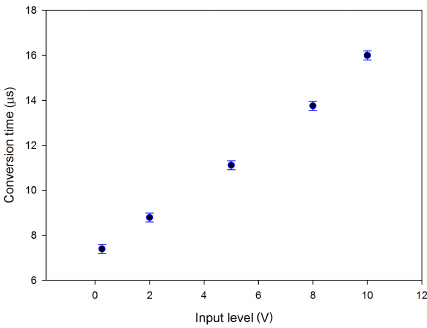
Figure 7. CANBERRA 8075 ADC conversion time. Values be- tween 7.2 and 16µs with an error rate of ±